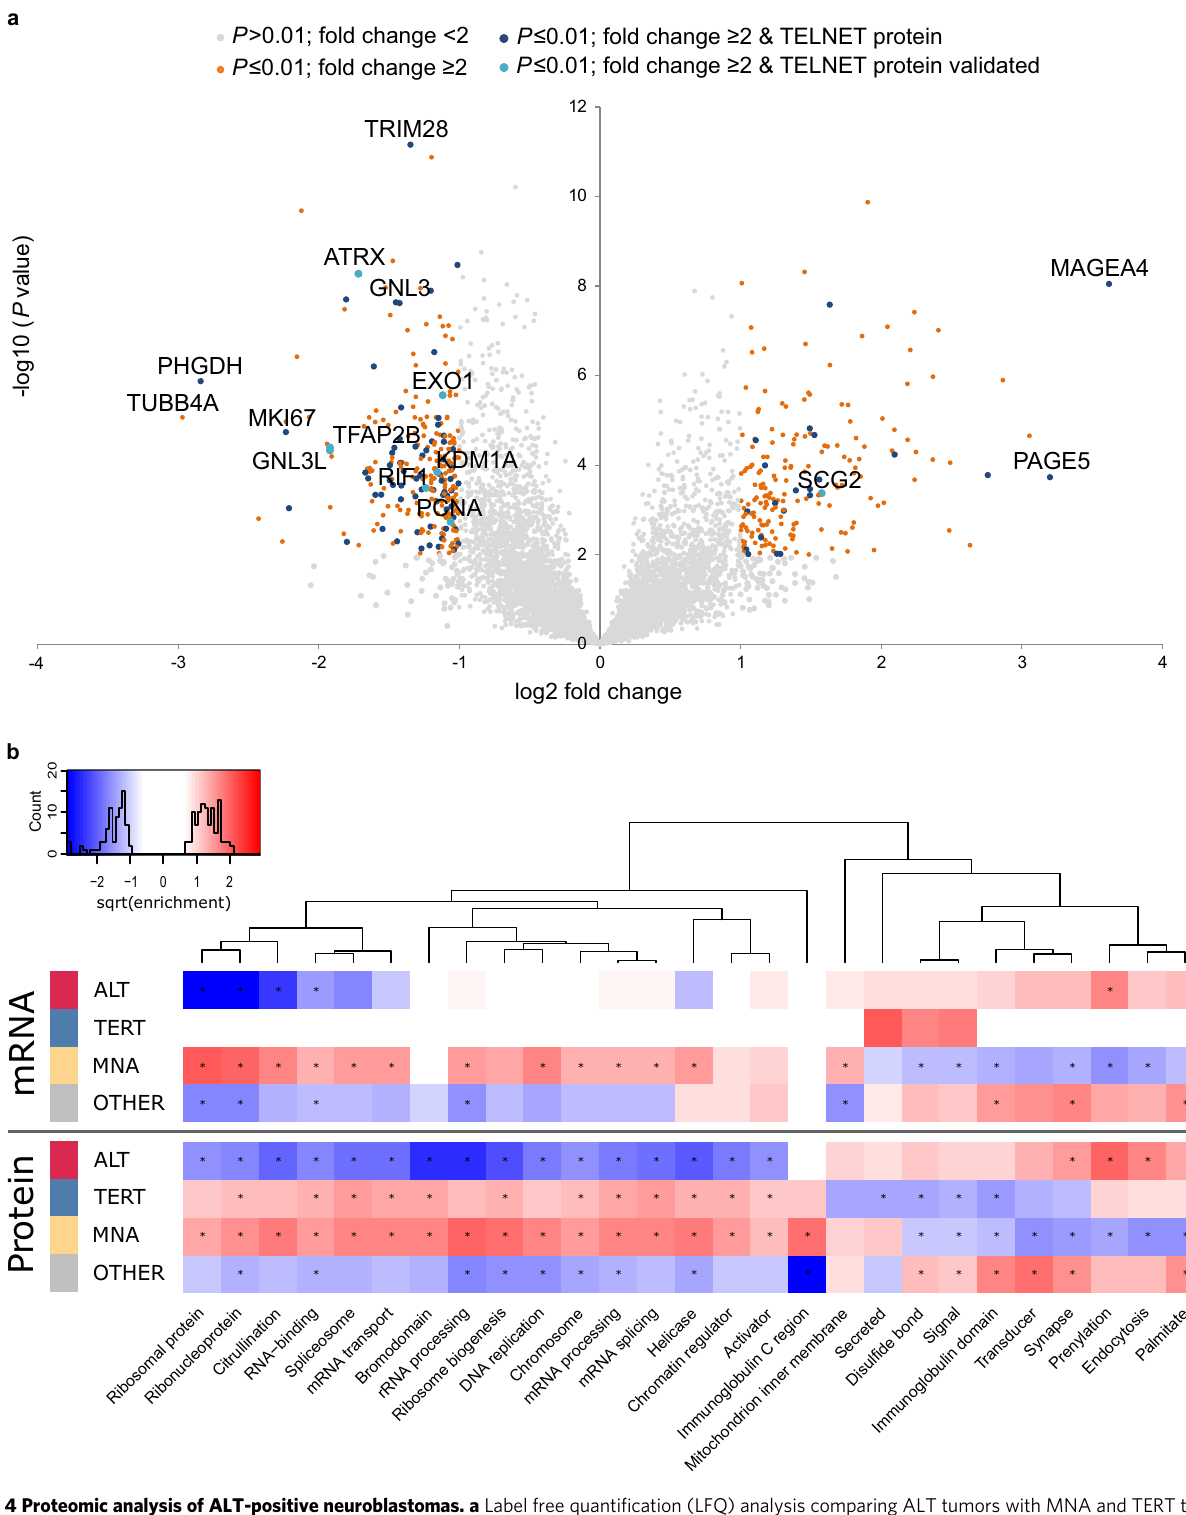
Fig. 4 Proteomic analysis of ALT-positive neuroblastomas. a Label free quanti fi cation (LFQ) analysis comparing ALT tumors with MNA and TERT tumors as well as tumors without a genetic telomere maintenance mechanism (OTHER). P values were calculated using a two-sided Student ’ s t -test. Colors indicate P value and fold change categories as well as the association to telomere biology based on the TelNet database 22 [https://malone2.bioquant.uni- heidelberg.de/fmi/webd/TelNet]. b Differences between neuroblastoma subtypes (ALT, TERT, MNA, OTHER). UniProt keywords ([https://www.uniprot. org/keywords/]; retrieved on 2016-11-02) with signi fi cant enrichments (BH adjusted P < 0.000005, at least 2.5-fold enriched, at least 3 protein/mRNAs per keyword) in at least one group with signi fi cantly more or less abundant mRNA or proteins comparing each group to all other samples in turn (BH adjusted P < 0.05, * marks signi fi cant enrichment). Positive and negative sqrt enrichment values for enrichments in more and less abundant mRNA or protein, respectively. Enrichment P values were calculated by hypergeometric test and multiple-testing adjusted by Benjamini – Hochberg method. Exact P values and individual proteins contributing to Uniprot keywords are given in Supplementary Data